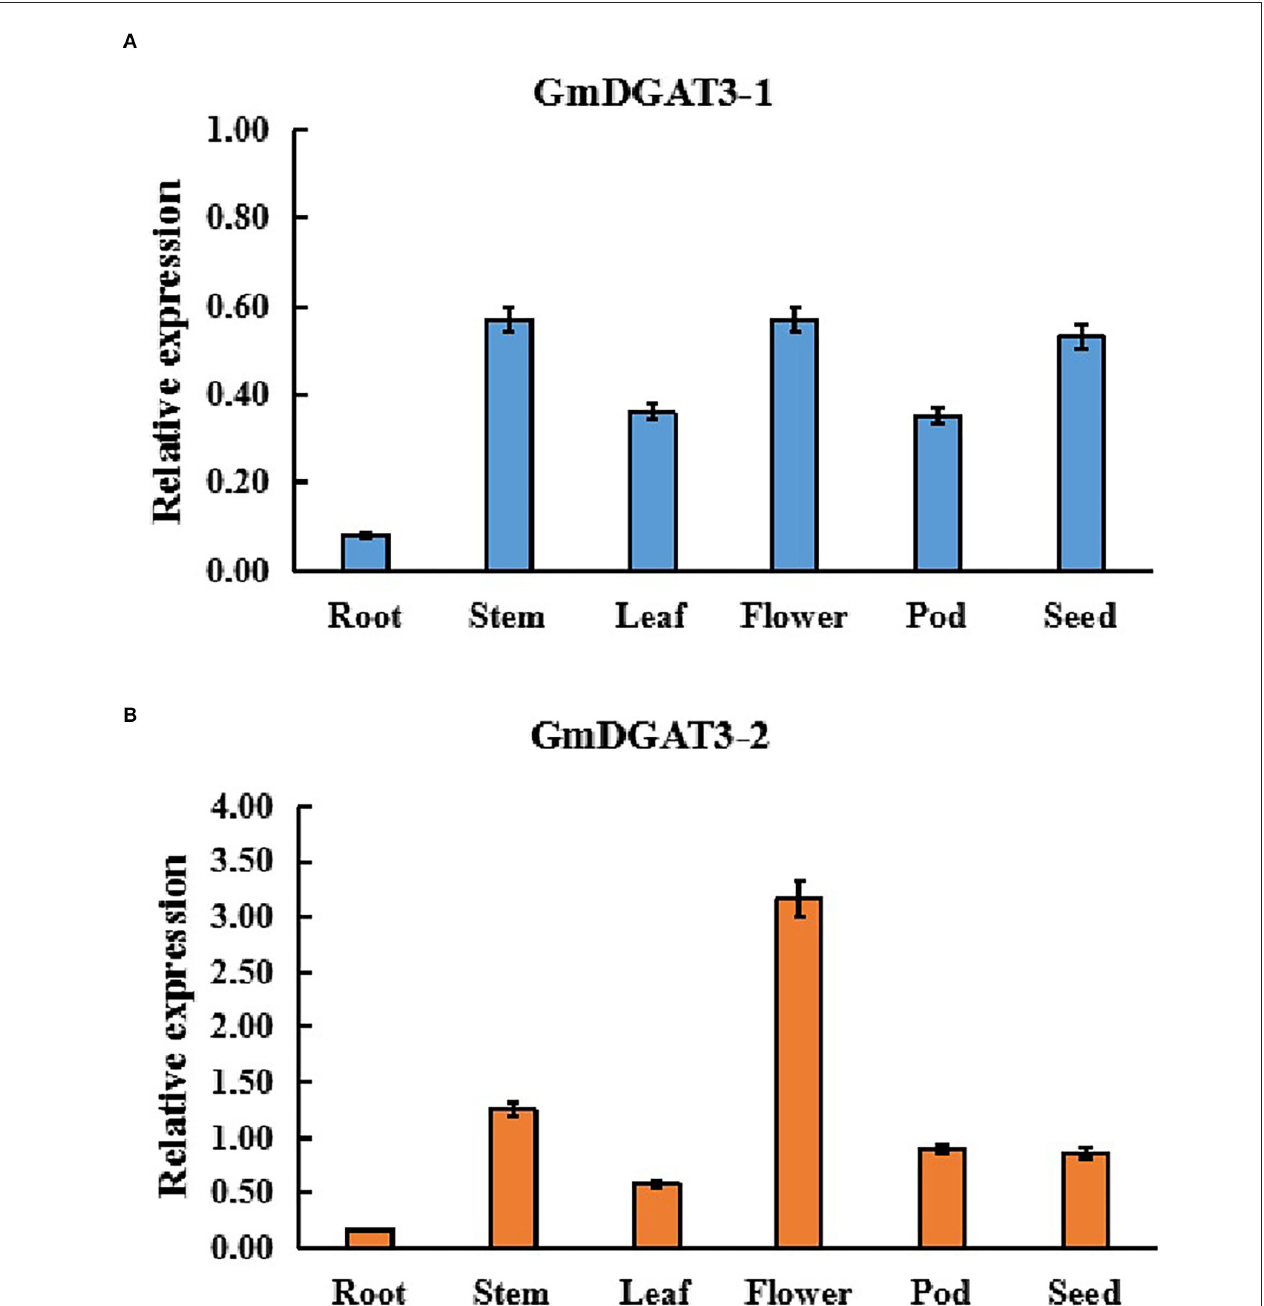
FIGURE 3 | Expression patterns of GmDGAT3-1 (A) and GmDGAT3-2 (B) in various soybean tissues. Pod: 45 DAF seed pod; Seed: 45 DAF seeds. The days after flowering (DAF) represent each developmental stage of soybean seeds. Data bars represent the mean ± STD level of relative transcript abundance from three biological